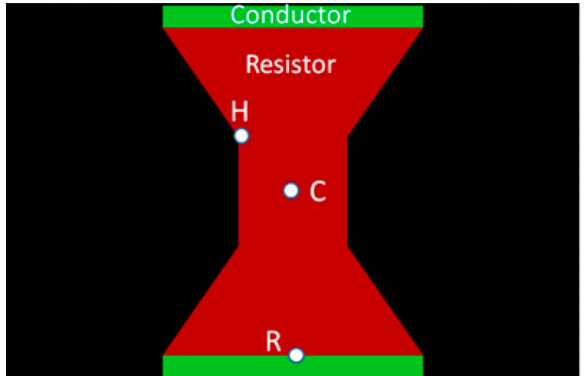
Figure 1. Geometry of the trapezoid resistor, with points H, C and R.